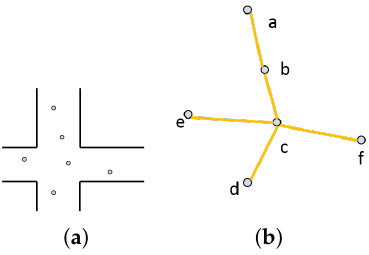
Figure 1. Topological network: ( a ) actual environment; ( b ) micro